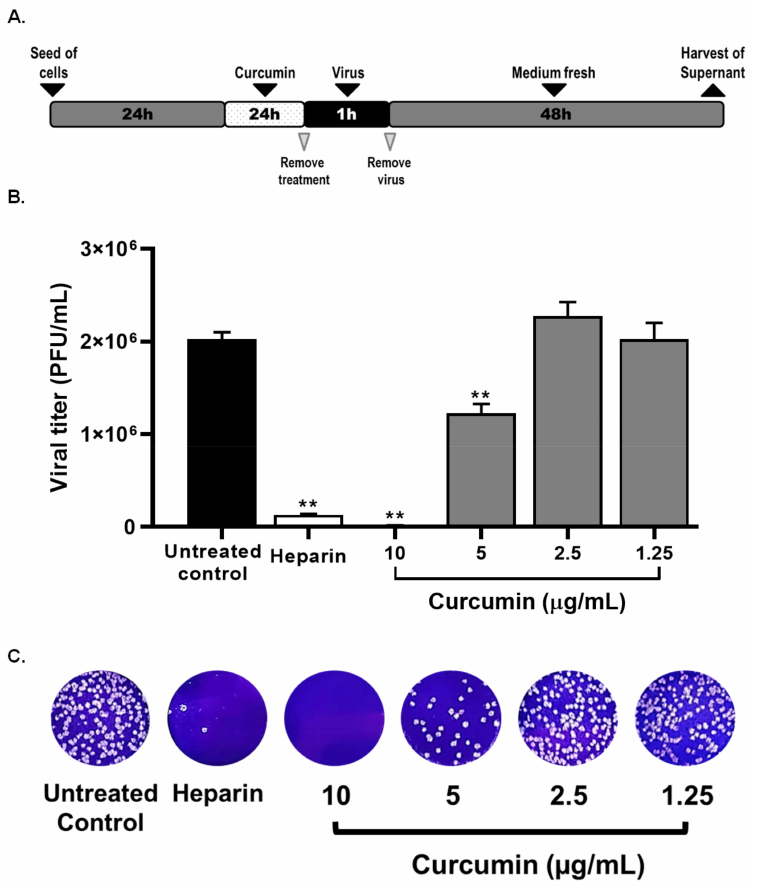
Figure 4. Curcumin inhibited SARS-CoV-2 by pre-infection treatment strategy. ( A ) Representative scheme of pre-infection treatment. ( B ) The figure represents the reduction of D614G strain titer (PFU/mL) on Vero E6 supernatants after pre-treatment with curcumin (from 1.25 to 10 µ g/mL). Heparin was used as a positive control of viral inhibition. Data were presented as median ± IQR (n = 4). Mann–Whitney test ** p ≤ 0.01. Inhibition percentages of 99.2%, 39.3%, − 12.8%, and − 0.4% were obtained at 10, 5, 2.5, and 1.25 µ g/mL of curcumin, respectively. ( C ) Representative plaques on Vero E6 cells of pre-treatment of curcumin against D614G